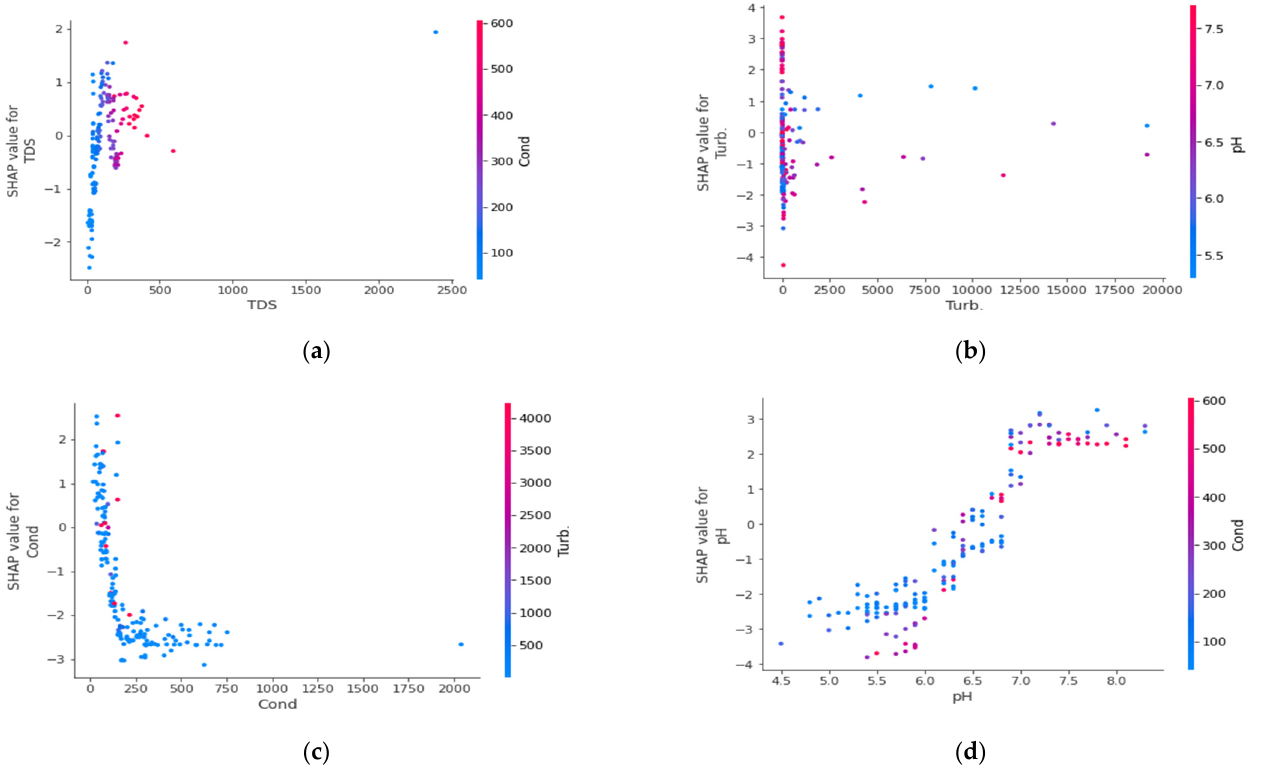
Figure 11. SHAP dependency and interaction effect plots for high As concentrations: ( a ) TDS; ( b ) Turb; ( c ) Cond; and ( d ) pH.